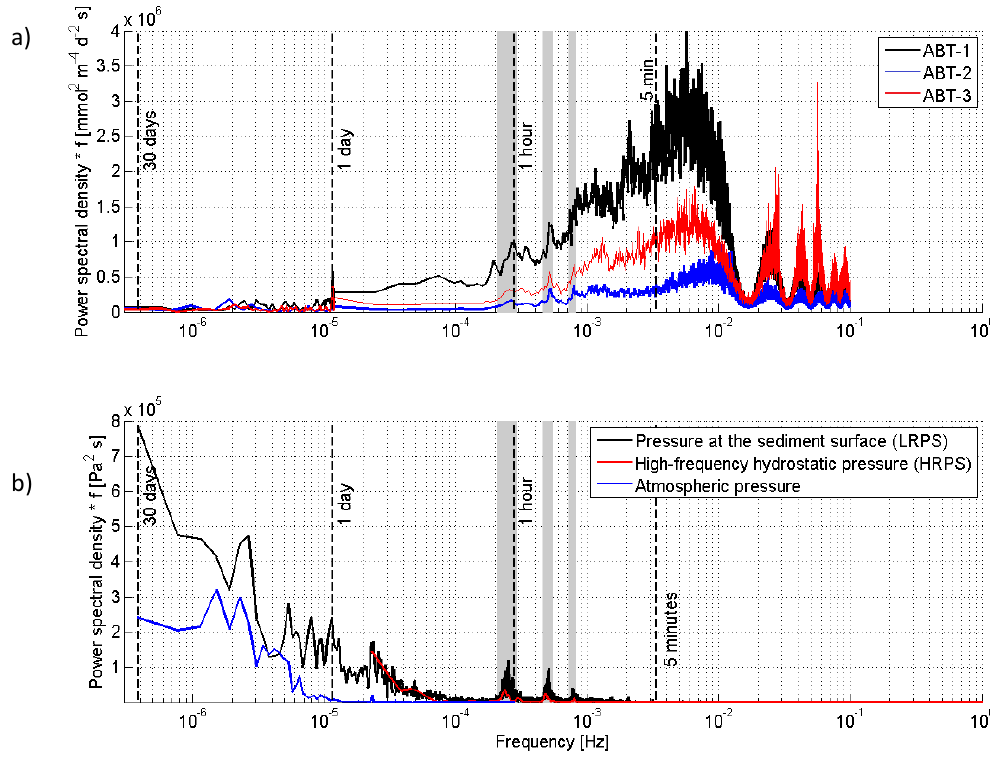
Figure 4. Variance-preserving power spectra of ebullition rates (a) and hydrostatic (LR-PS and HR-PS) and atmospheric pressure in (b) . Peaks at 15min, 30min and 1h are marked in grey and caused by ship lock-induced surges. Table 1. Monthly mean ± SD and overall mean ± SD concentrations of CH 4 in deliberately released and captured bubbles of the three automated bubble traps (ABTs) during the entire sampling